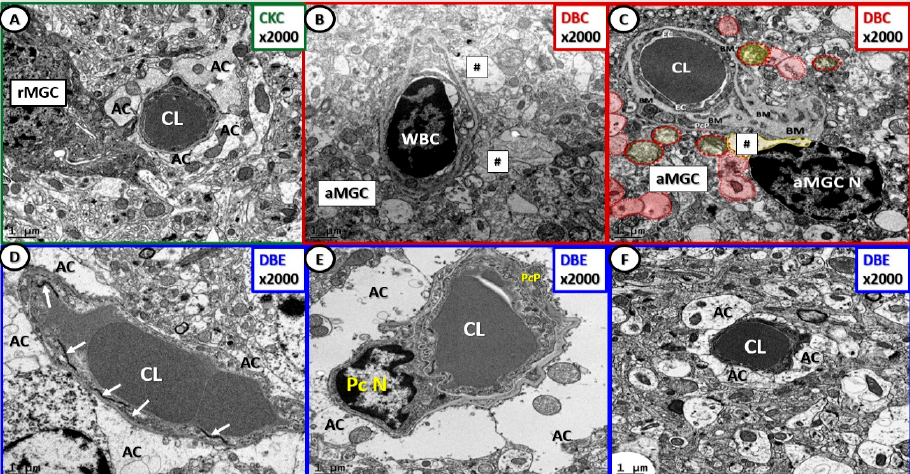
Figure 3. Empagliflozin protects the NVU from basement membrane (BM) thickening, loss of blood–brain barrier endothelial tight and adherens junctions and pericytes. Panel ( A ) depicts the normal ultrastructure morphologic phenotype of the NVU in the CKC. Panels ( B ) and ( C ) depict thickening